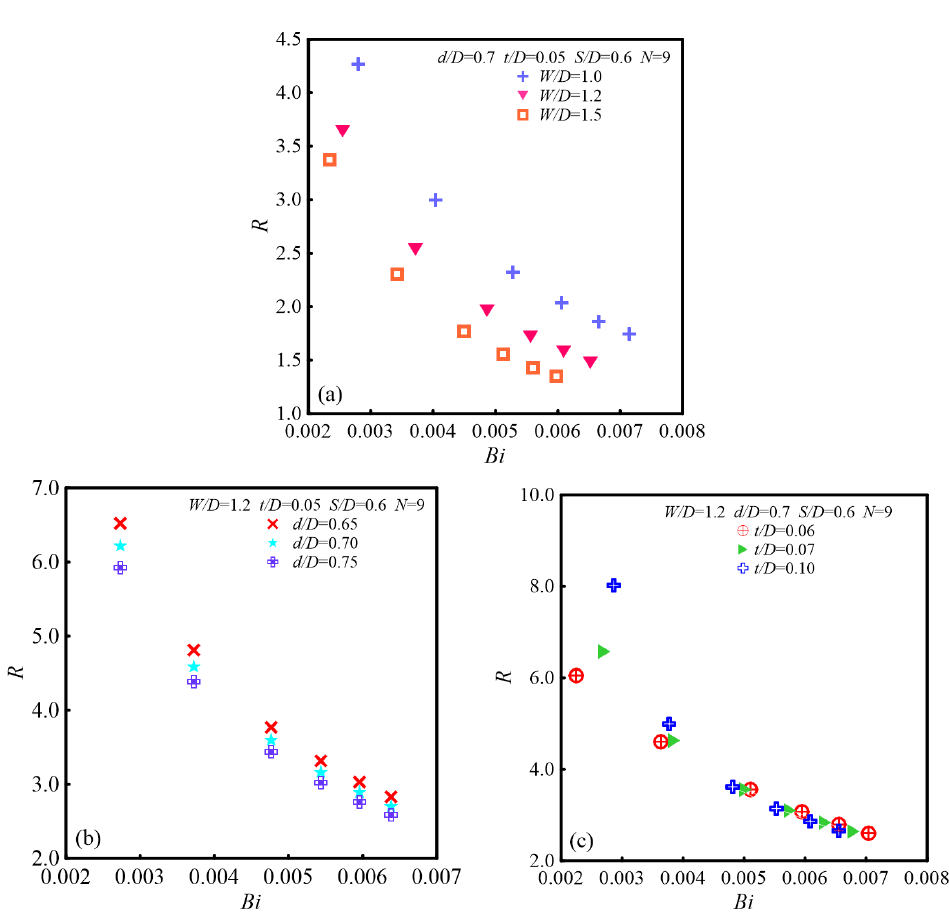
Fig. 10. Effect of W/D , d/D , and t/D on R